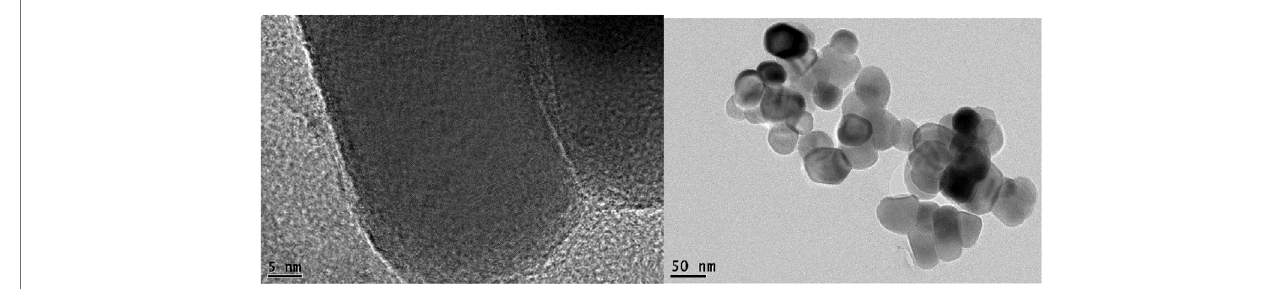
FIGURE 6 | TEM images of PW:FS054 at different magni fi cations.